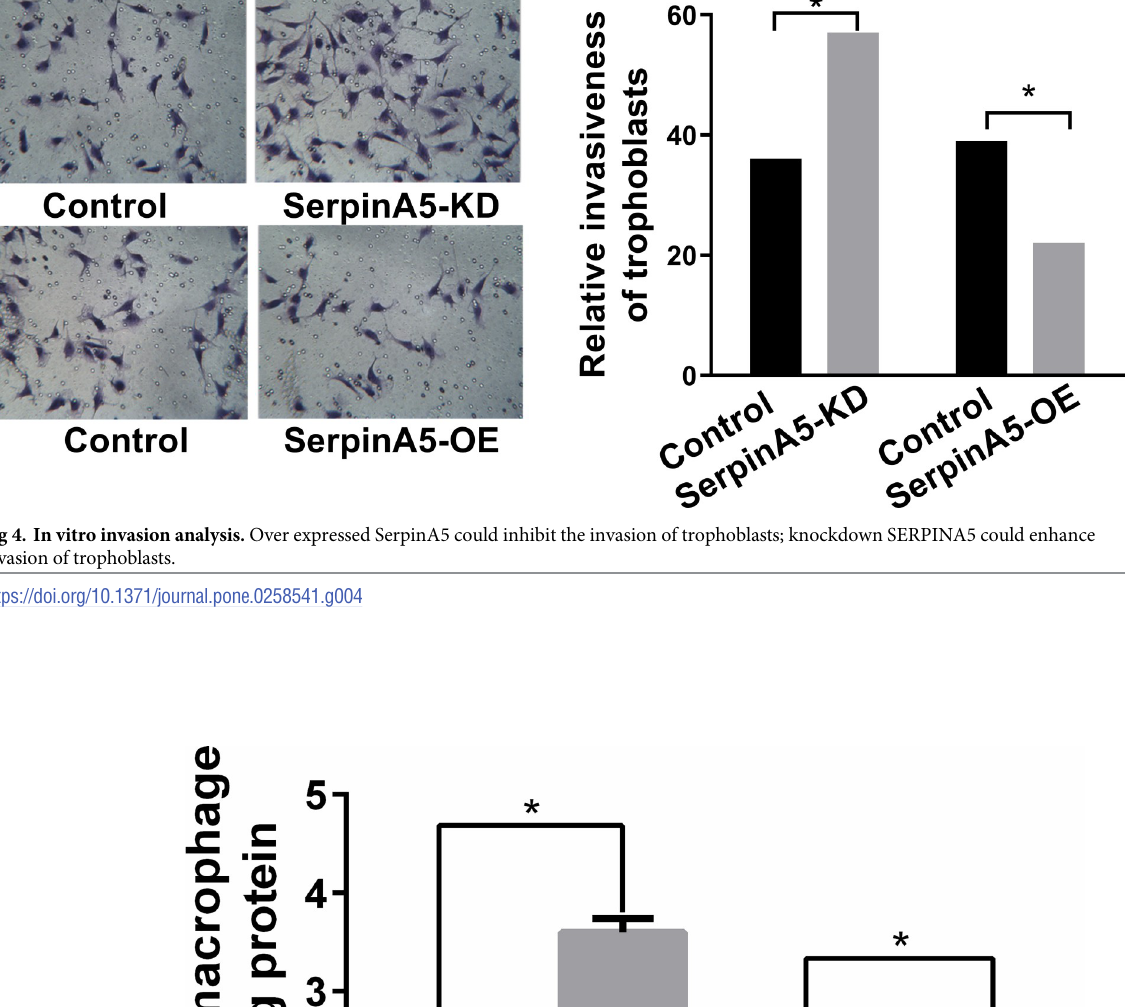
PLOS ONE | https://doi.org/10.1371/journal.pone.0258541 October 14,